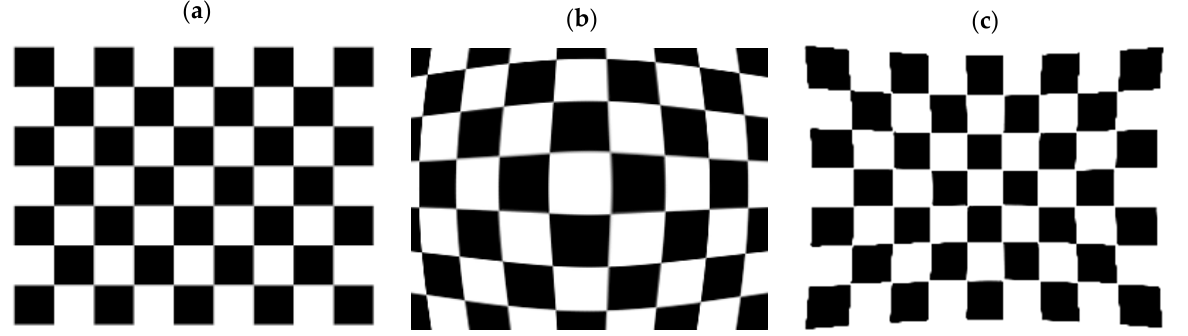
Figure 1. A schematic representation of a typical checkerboard with ( a ) no distortion, ( b ) barrel distortion and ( c ) pincushion distortion.